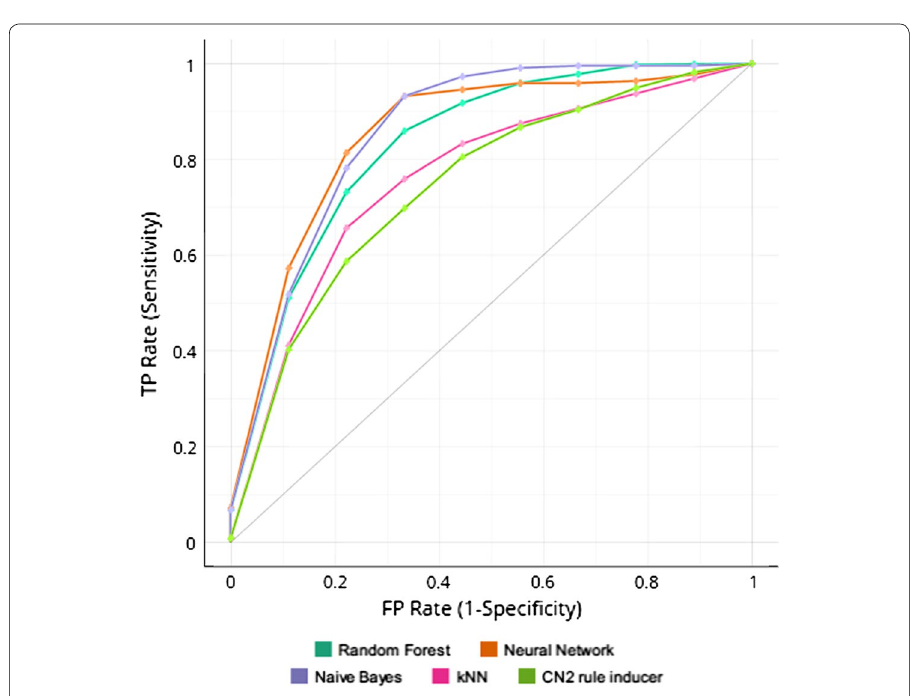
Fig. 10 ROC for the HDT IP download